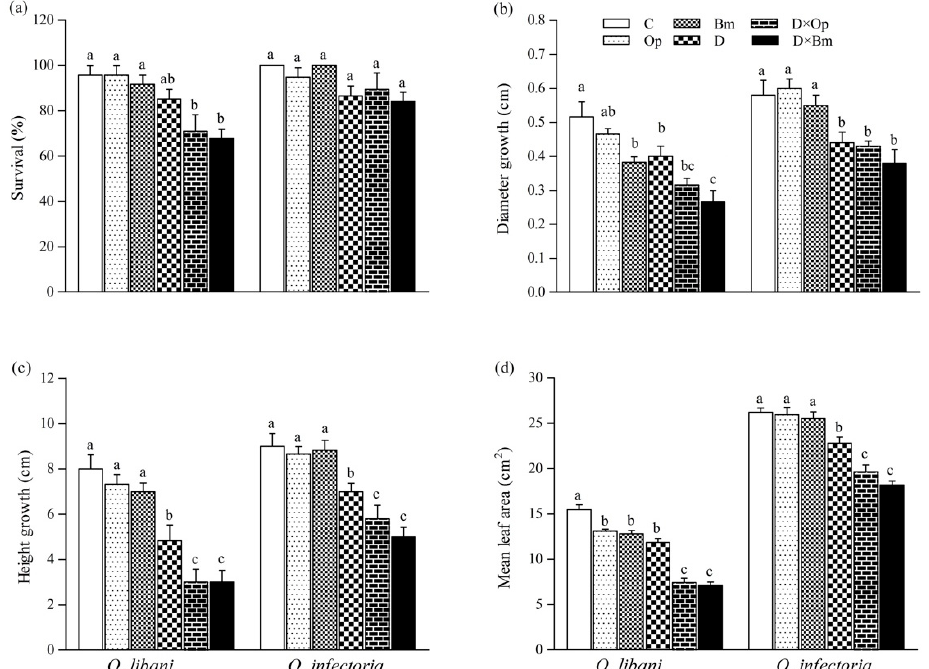
Figure 3. ( a ) Survival, ( b ) diameter growth, ( c ) height growth, and ( d ) average leaf area of Quercus libani and Q. infectoria seedlings affected by charcoal disease and drought (Op: Obolarina persica , Bm: Biscogniauxia mediterranea , D: Drought, D × Op: Drought × O. persica and D × Bm: Drought × B. mediterranea ). Bars represent means + standard error, n = 6. Different lower-case letters indicate statistically significant differences between the treatments at α = 0.05 based on Tukey’s multiple comparison test.